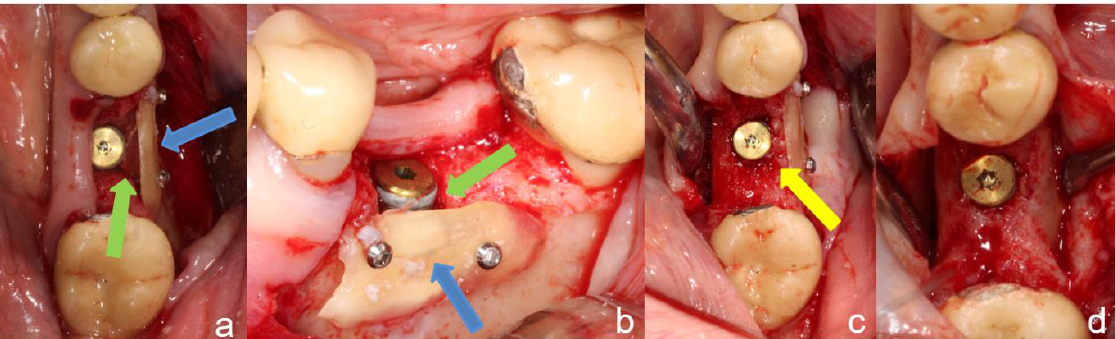
Figure 2. Clinical procedure of the tooth shell technique. ( a , b ) Occlusal and lateral view: Inserted implant at the site of tooth 36. The vestibular bone deficit is shown by the green arrows. Dentin shell fixed with osteosynthesis screws to the vestibular aspect of the implant (blue arrows). ( c ) The hollow space created between the dentin shell and implant was filled with particulate dentin (yellow arrow). ( d ) Occlusal view at the time of implant exposure with removed osteosynthesis screws. The implant seems to be fully osseointegrated with a stable laterad ridge lateral augmentation.